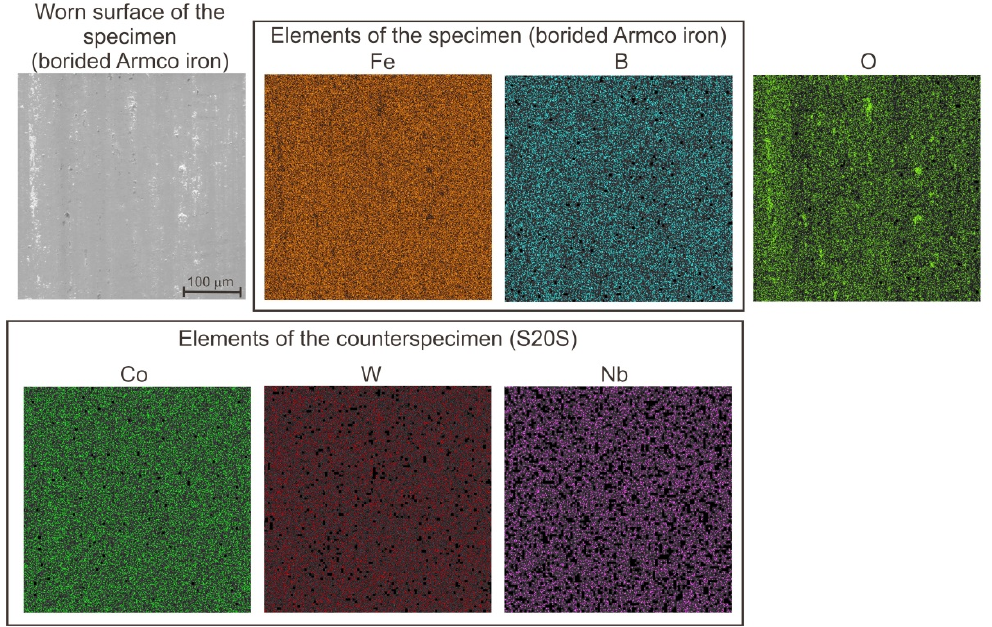
Figure 10. The worn surface and EDS pattern of gas borocarburized Armco iron.